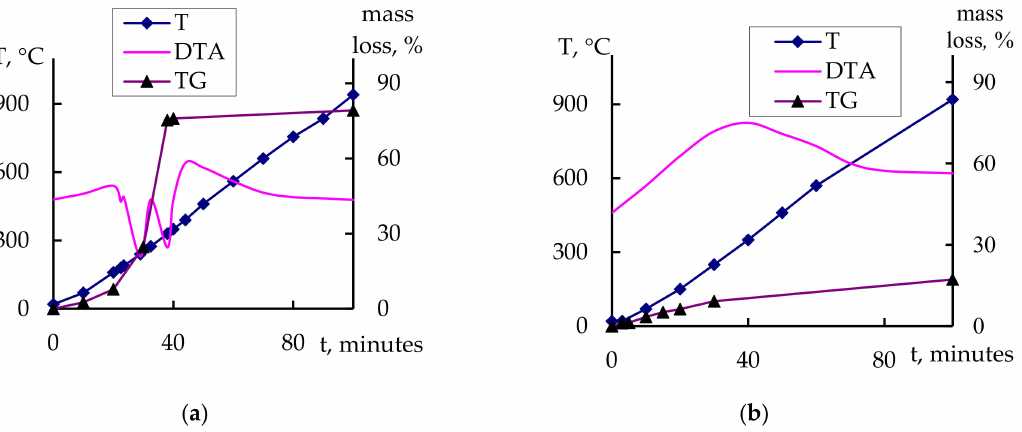
Figure 12. TGA curves: ( a ) after heat treatment at 100 ◦ C for 50 h; ( b ) after heat treatment at 100 ◦ C